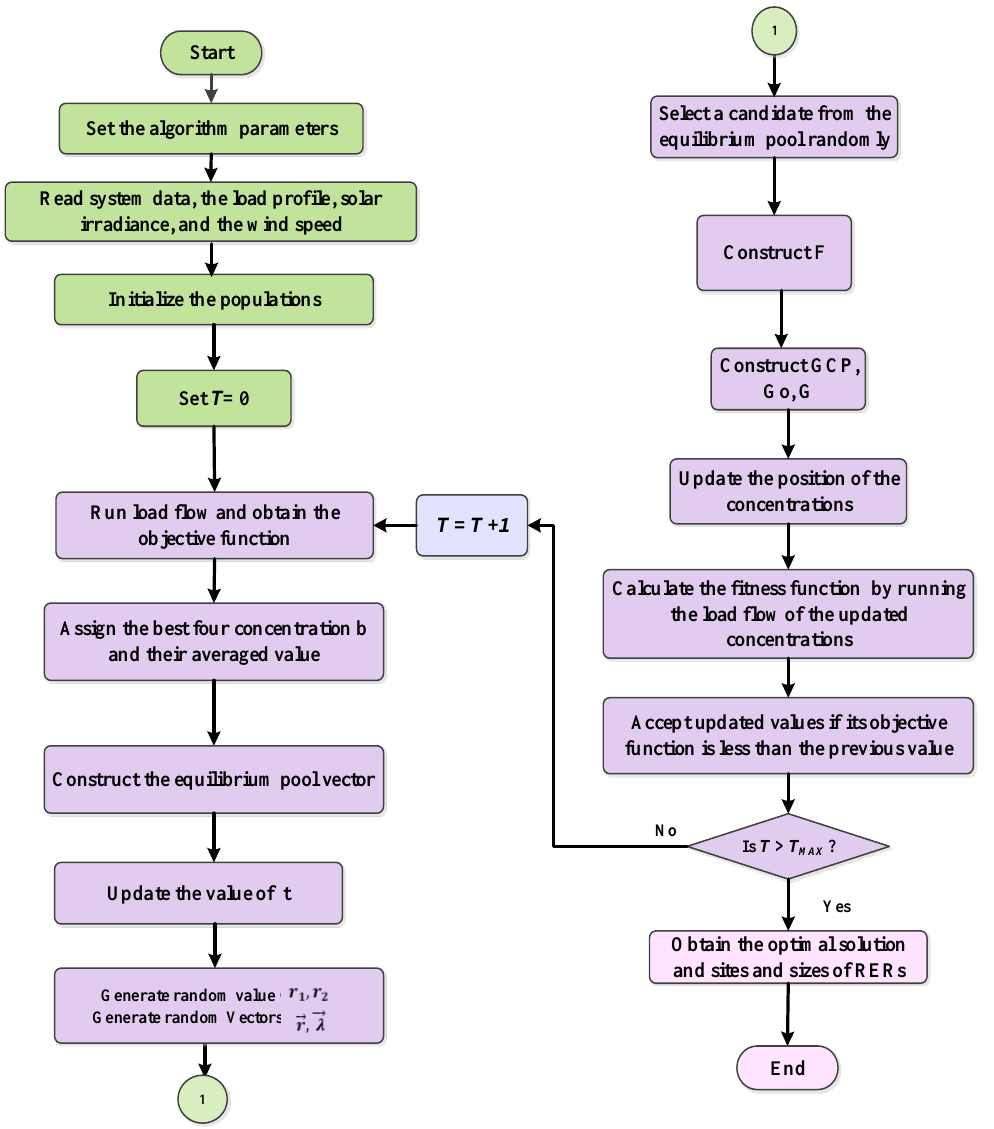
Figure 1. Flow chart for application of the equilibrium optimizer (EO) for optimal energy manage- ment.